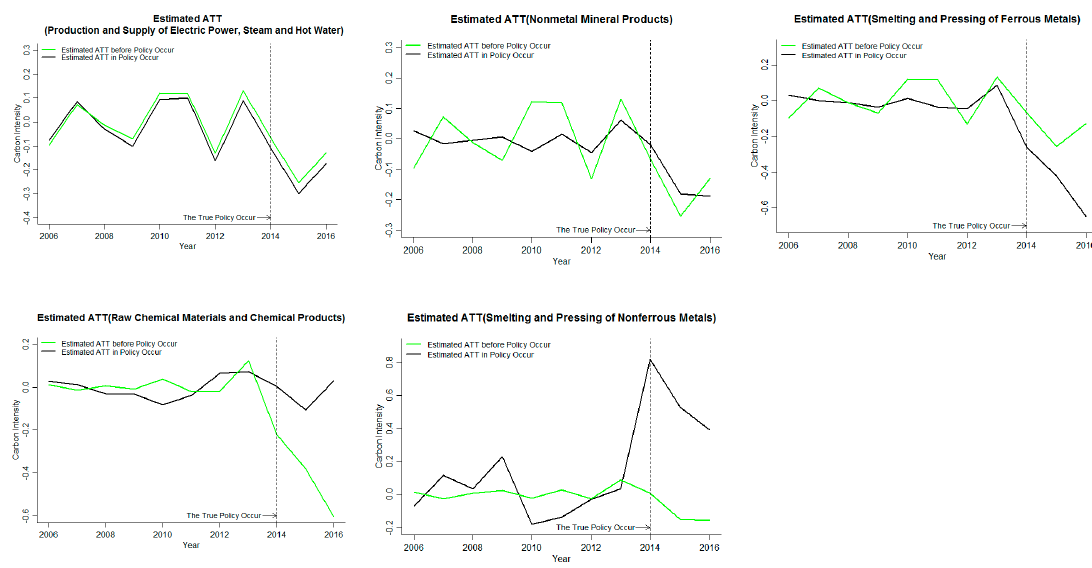
Figure 8. Industry robustness test results in Chongqing.